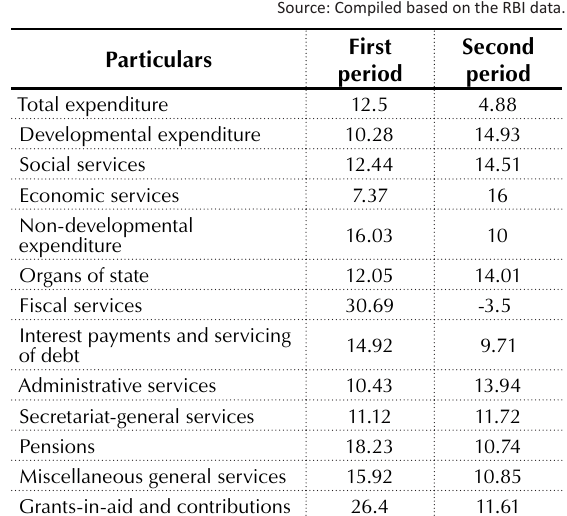
Table 2. Maharashtra and revenue